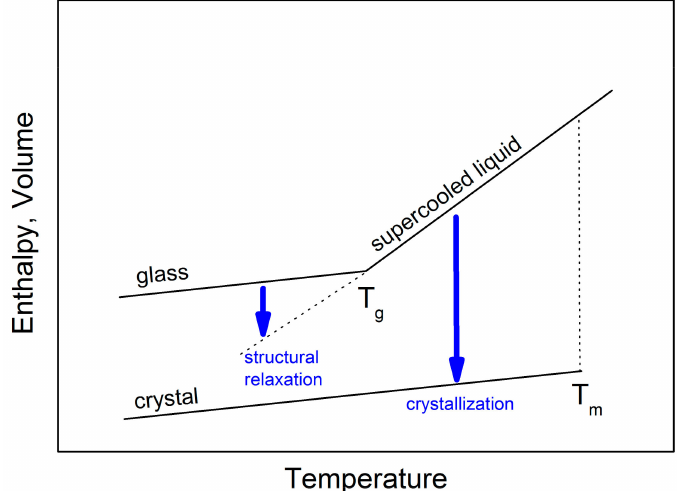
Figure 1. Schematic diagram showing the change in enthalpy and volume during glass formation, structural relaxation and